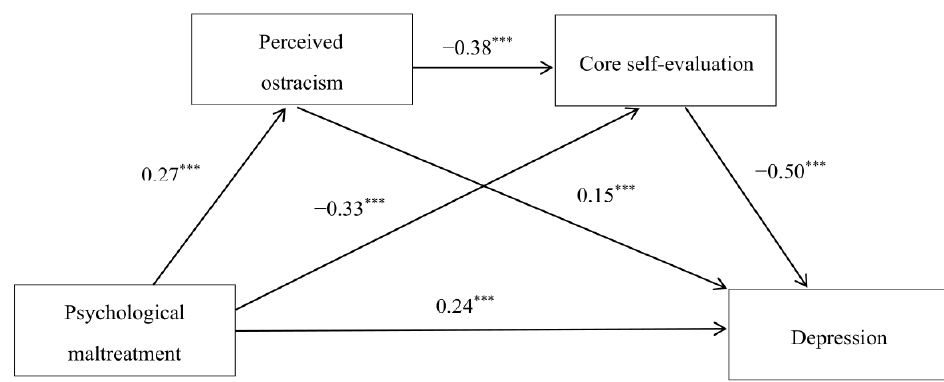
Figure 2. Results of the multiple mediation analysis for depression. *** p < 0.001. N = 1592.